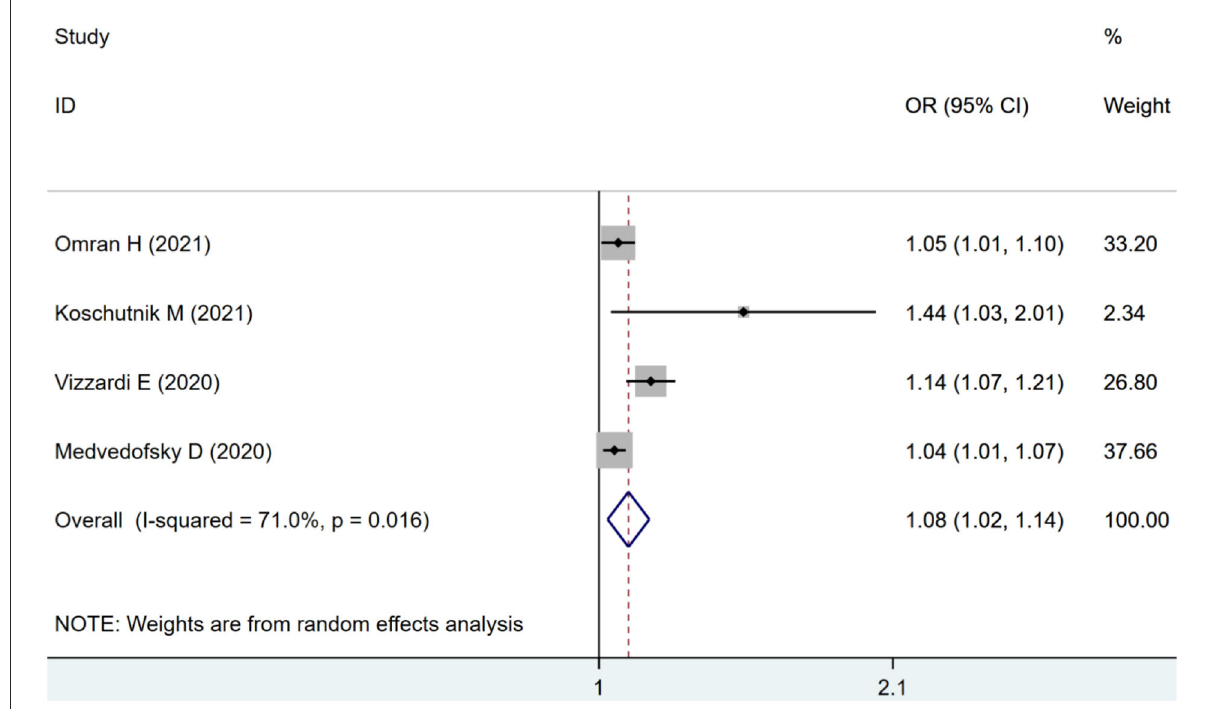
FIGURE3 Forest plot demonstrating the association between RVLS and combined ACM and MACE in patients with AS undergoing